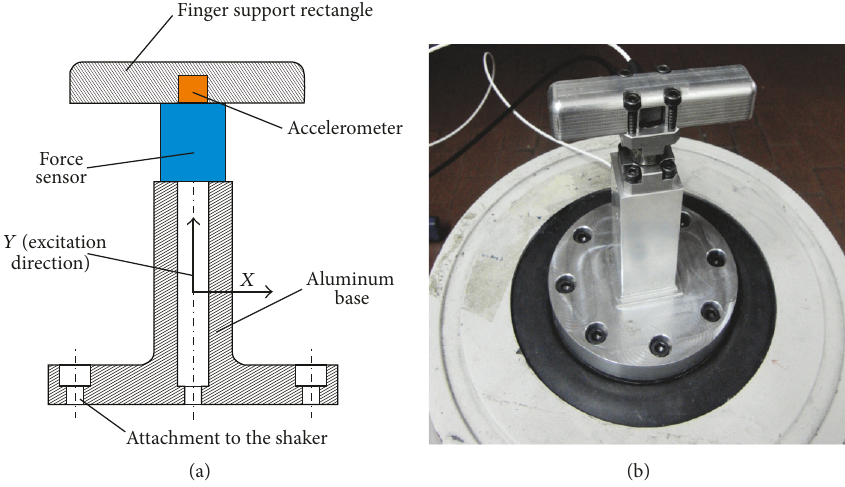
Figure 5: The measuring device: (a) a sketch of the device; (b) a photograph of the device.